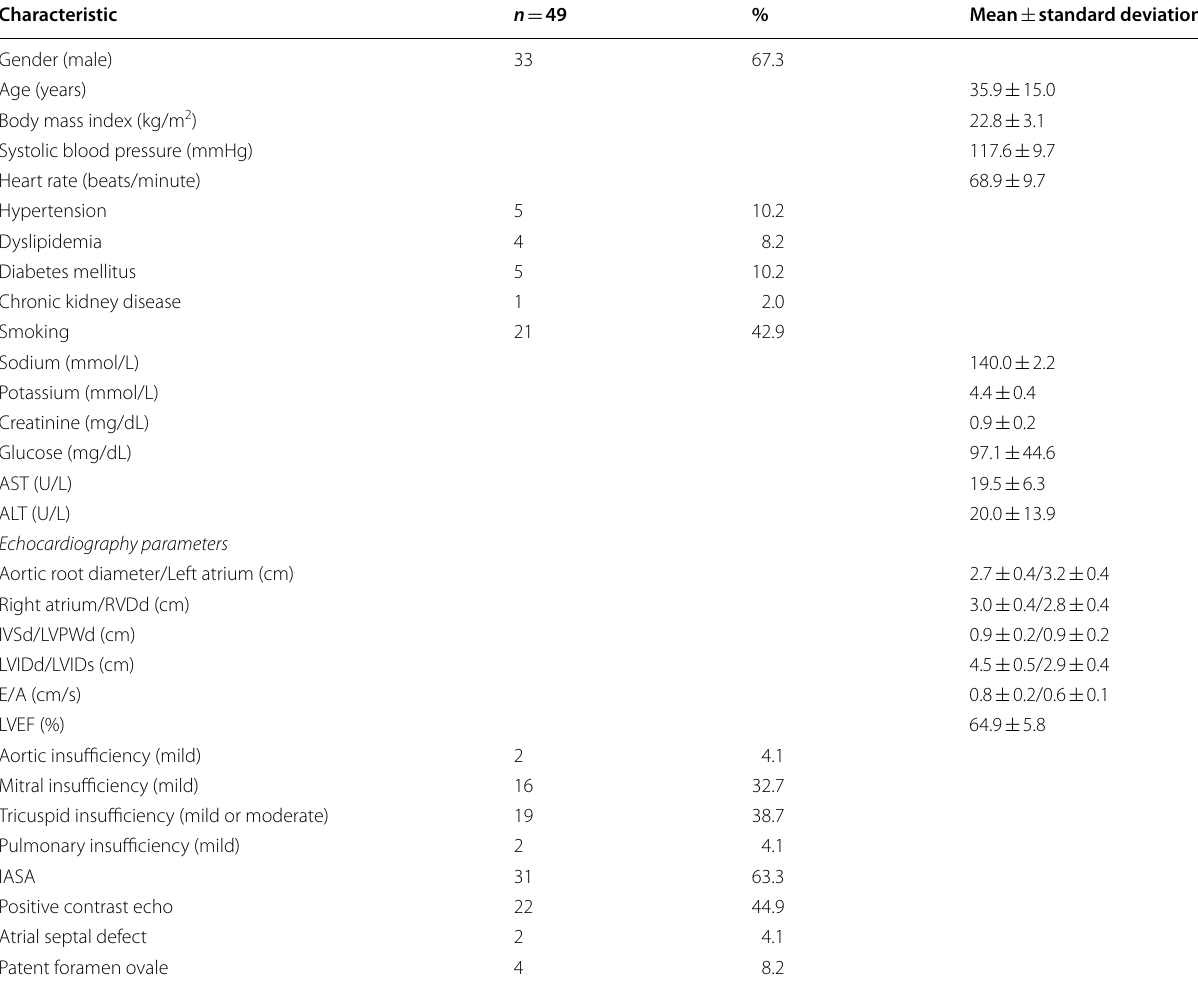
Table 1 Demographic, echocardiographic, and laboratory findings of the patients with Chiari